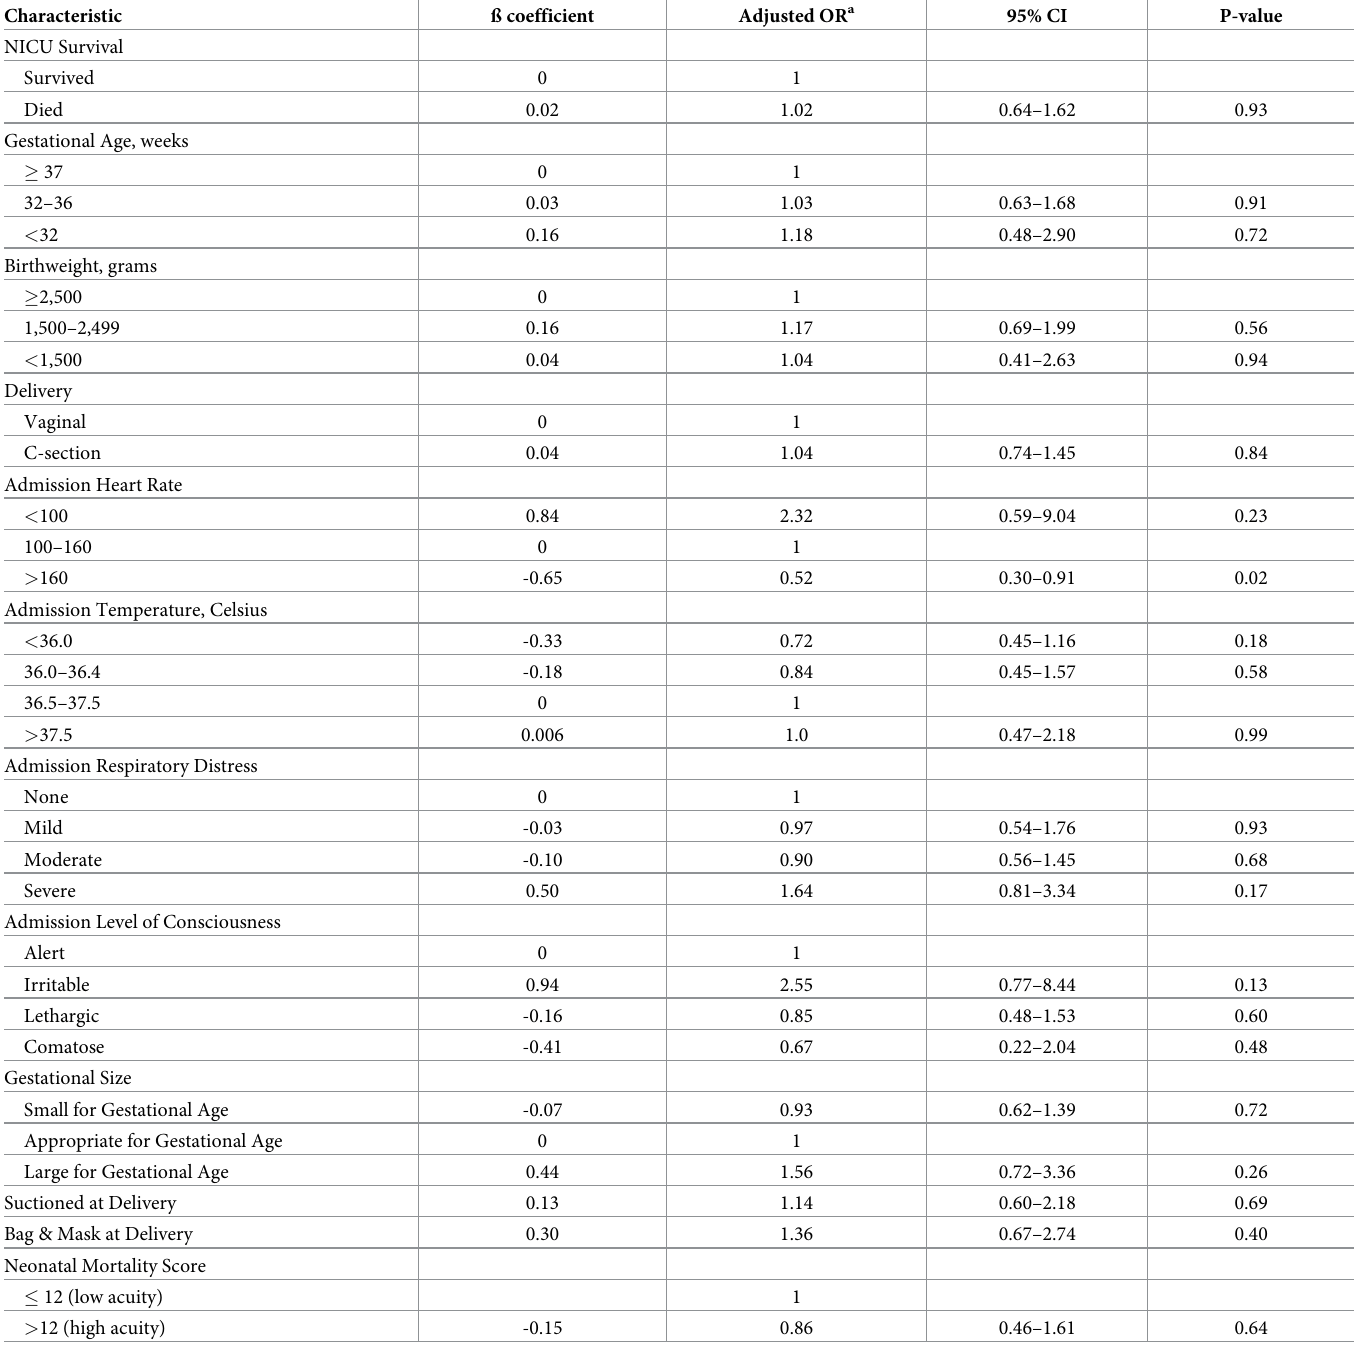
Table 3. Multivariate analysis comparing daytime and overnight NICU